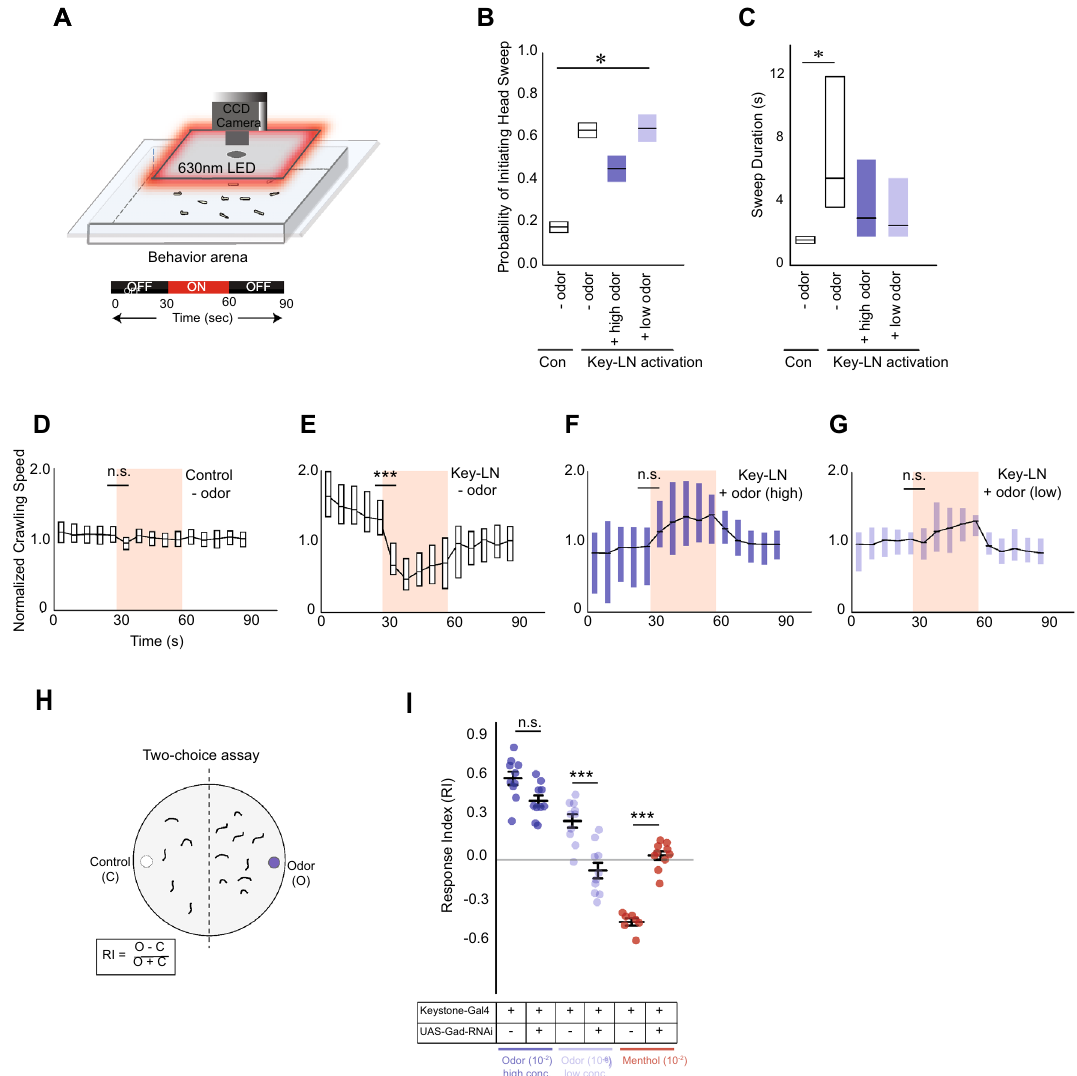
Figure 4. Keystone-LN-induced behavior in the presence of odor. ( A ) Transgenic larvae expressing CsChrimson in Keystone-LN are subjected to the optogenetics assay in the absence or presence of an odor (4-hexen-3-one). ( B ) The probability of head sweeps is plotted on the y-axis for control larvae expressing no CsChrimson in any neurons and for larvae expressing CsChrimson in Keystone-LN both in the absence or presence of a high (10 –2 vol:vol, dark blue) and a low (10 –6 vol:vol, light blue) concentrations of 4-hexen-3-one. Distributions are generated by bootstrap analysis. *p = 2e−16, n = 20,000 for each group. ( C ) The duration of each head sweep is plotted on the y-axis. *p = 0.0001, No odor, − activation, n = 8, No odor, + activation n = 51, High odor, + activation n = 16, Low odor, + activation n = 20. ( D – G ) The normalized crawling speed of the larvae over the course of the experiment (90 s) is plotted on the y-axis. Control larvae in the absence of odor ( D ) and larvae expressing CsChrimson in Keystone-LN in the absence of odor ( E ), in the presence of high odor concentration ( F ), and in the presence of low odor concentration ( G ) are shown. ***p < 0.001, n = 32. ( H ) 2-choice behavior assay. Attraction to test odor is measured as a response index (RI) based on the number of larvae in each half of the plate. ( I ) RI values (mean, SEM) of control and test larvae expressing Gad-RNAi in Keystone-LN are plotted on the y-axis. Responses to a high concentration (10 –2 vol:vol, dark blue dots) and a low concentration (10 –6 vol:vol, light blue dots) of an attractive odor (4-Hexen-3-one) and to a high concentration (10 –2 vol:vol, red dots) of an aversive odor (menthol) are shown. Factorial ANOVA, Tukey posthoc test, ***p < 0.001, n = 10 (parent control); n = 10 (test